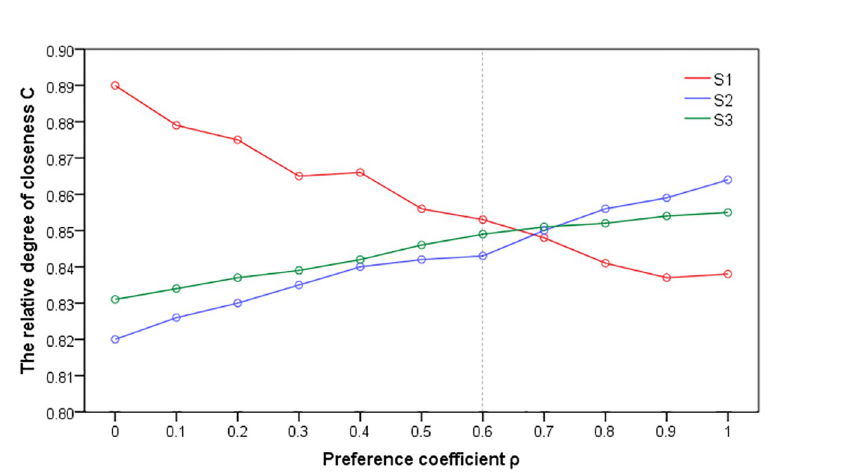
Fig 4. Sensitivity analysis chart of the preference